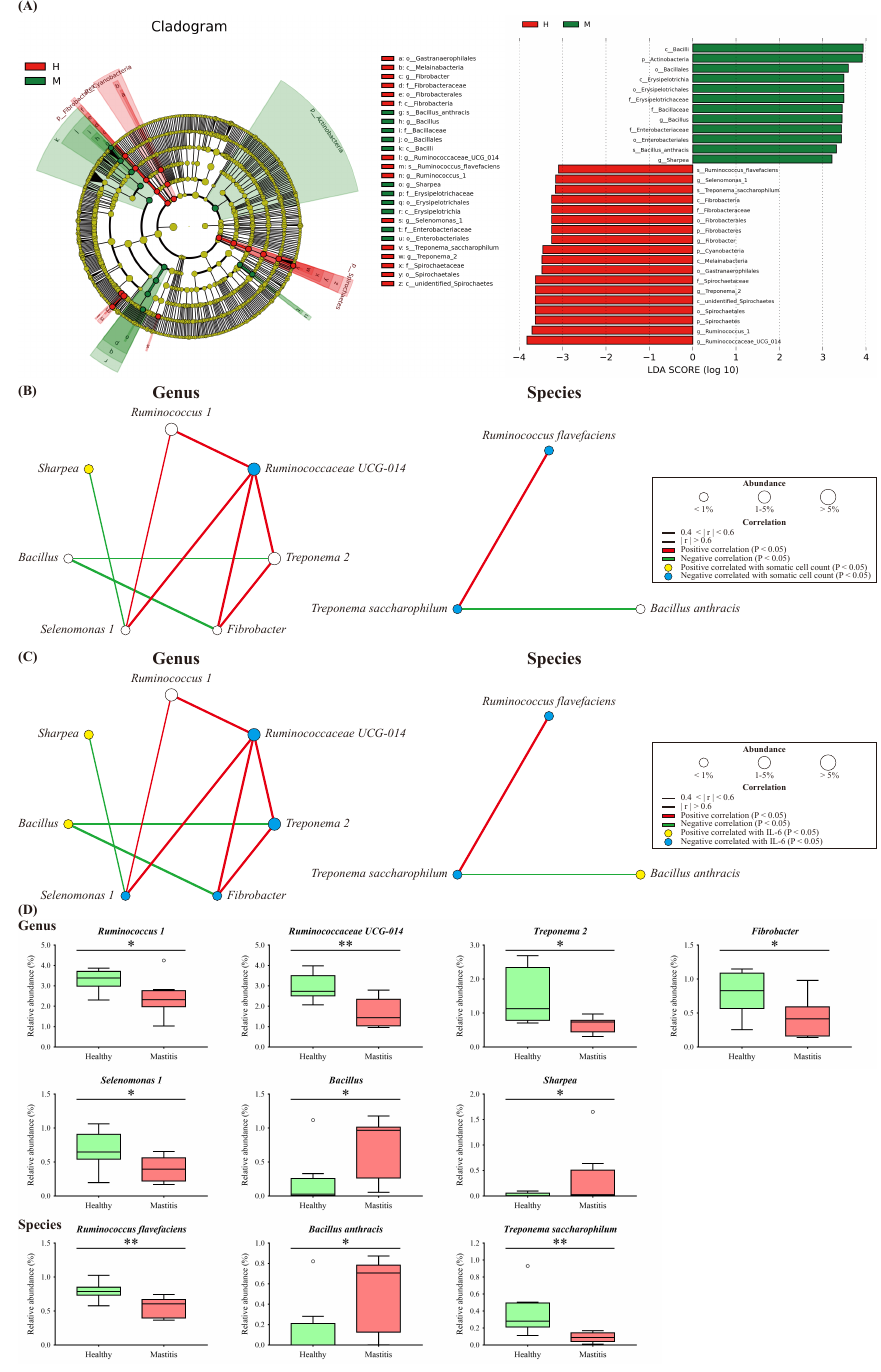
Figure 4. Significant differential biomarkers were identified using the linear discriminant analysis (LDA) effect size (LEfSe) algorithm. ( A ) LEfSe cladogram and log-transformed LDA scores illustrate differential enrichment of biomarkers between groups. Bacterial networks of ruminal microbiota show the correlations between the seven genus and three species with ( B ) SCC and ( C ) IL-6. Each node represents a biomarker and the size corresponds to its relative abundance. Yellow and blue nodes show significant positive and negative correlations with somatic cell count/IL-6 ( p < 0.05), respectively. Red and green edges indicate significant positive and negative correlations between biomarkers ( p < 0.05), respectively. ( D ) The significant relative abundance of differential biomarkers. Symbols indicate significantly different relative abundances between groups using the Mann–Whitney U test (* p < 0.05; ** p <